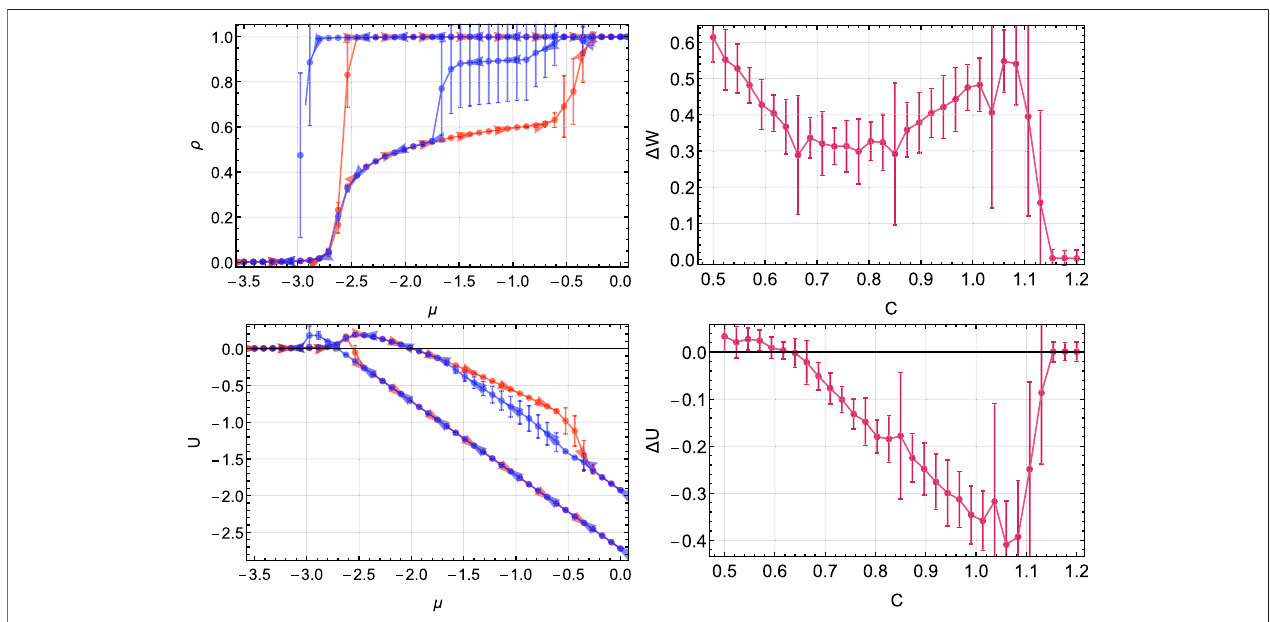
FIGURE6| HysteresisinthethermodynamicvariablesfordifferentvaluesofC.Lightcolorsarefor C (cid:1) 0 . 64anddarkercolorsarefor C (cid:1) 1 . 0367.Theintegralofthe curve is shown in the right side.